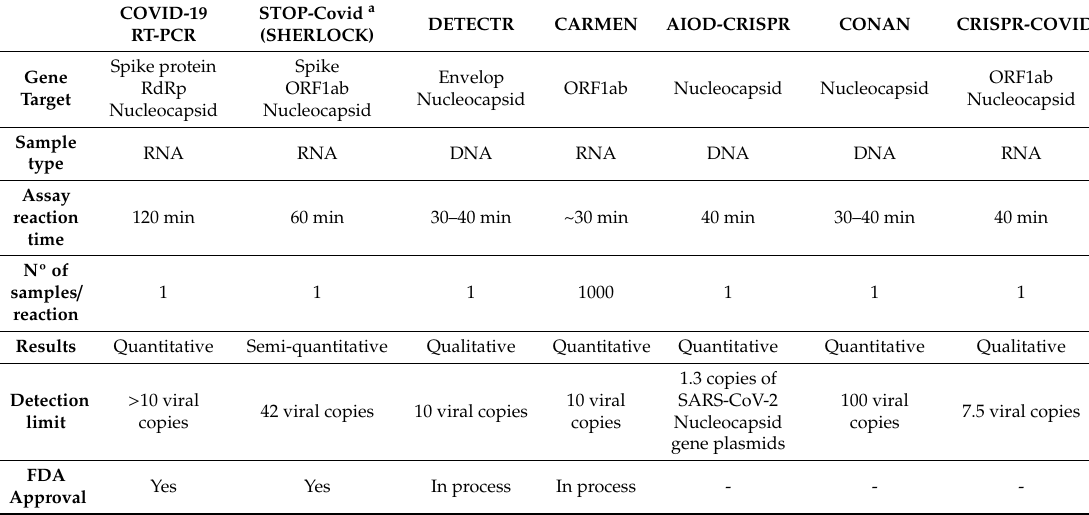
Table 2. Comparison of the main characteristics of some novel diagnostic methods for SARS-CoV-2 and the gold standard COVID-19 RT-PCR